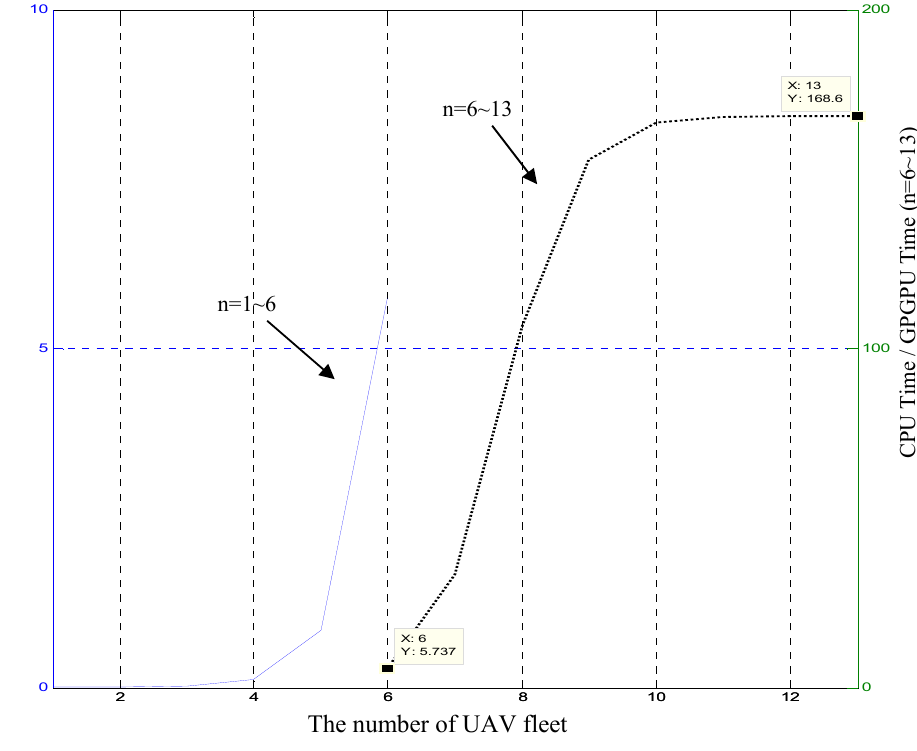
Figure 8. Plot of performance ratio (CPU time/GPGPU time).